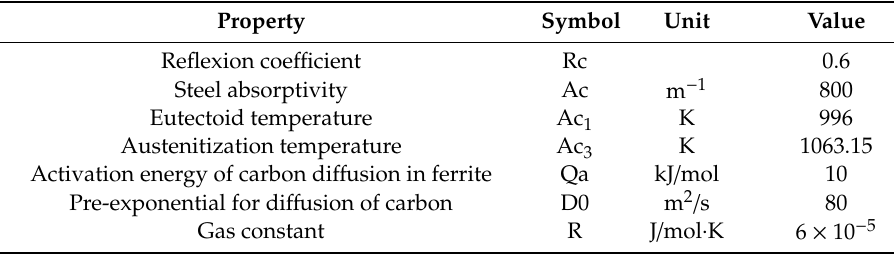
Table 2. Material properties of AISI 4340 alloy steel